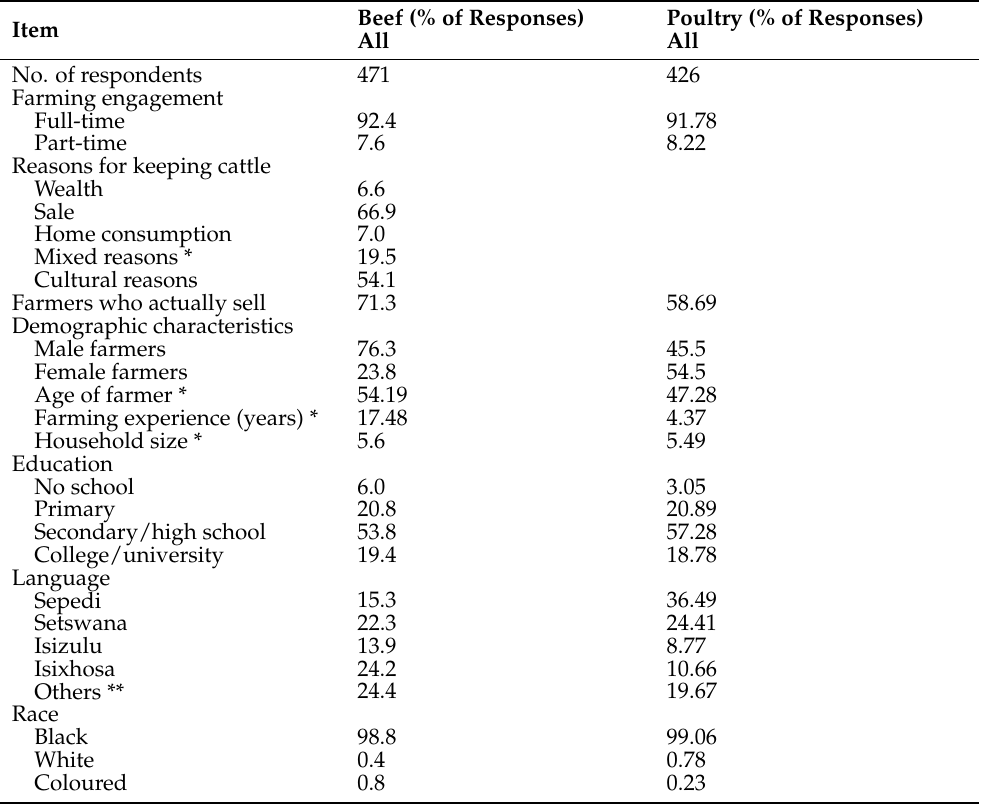
Table 1. Profile of farmer